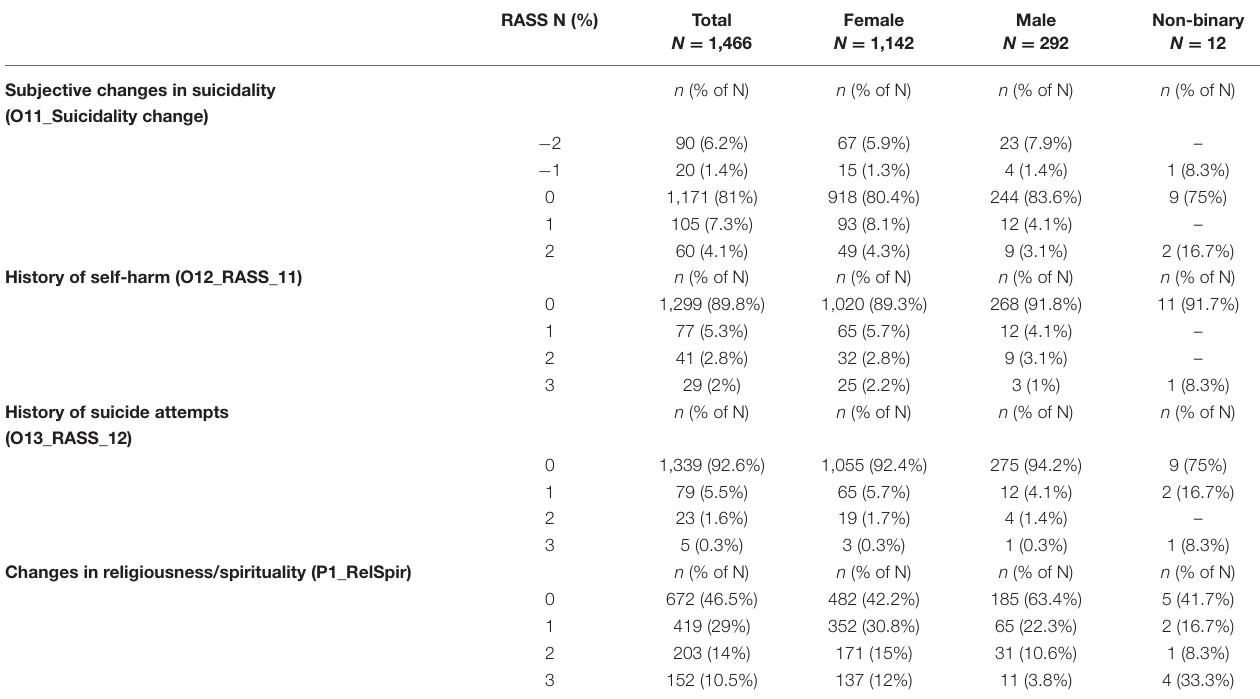
TABLE 4 | The scorings’ distributions for the individual items on suicidality change, personal history of self-harm, and increase in religious/spiritual inquiries. RASS N (%)